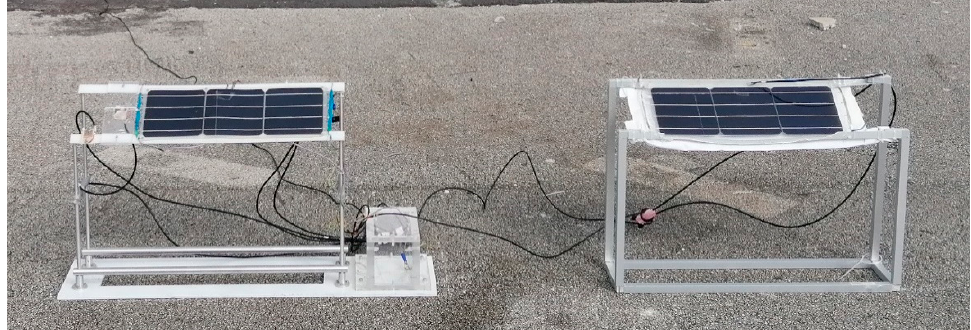
Figure 1. Image of the experimental setup: front view of the two minimodules, with the bifacial on the left and the monofacial on the right . the left and the monofacial on the